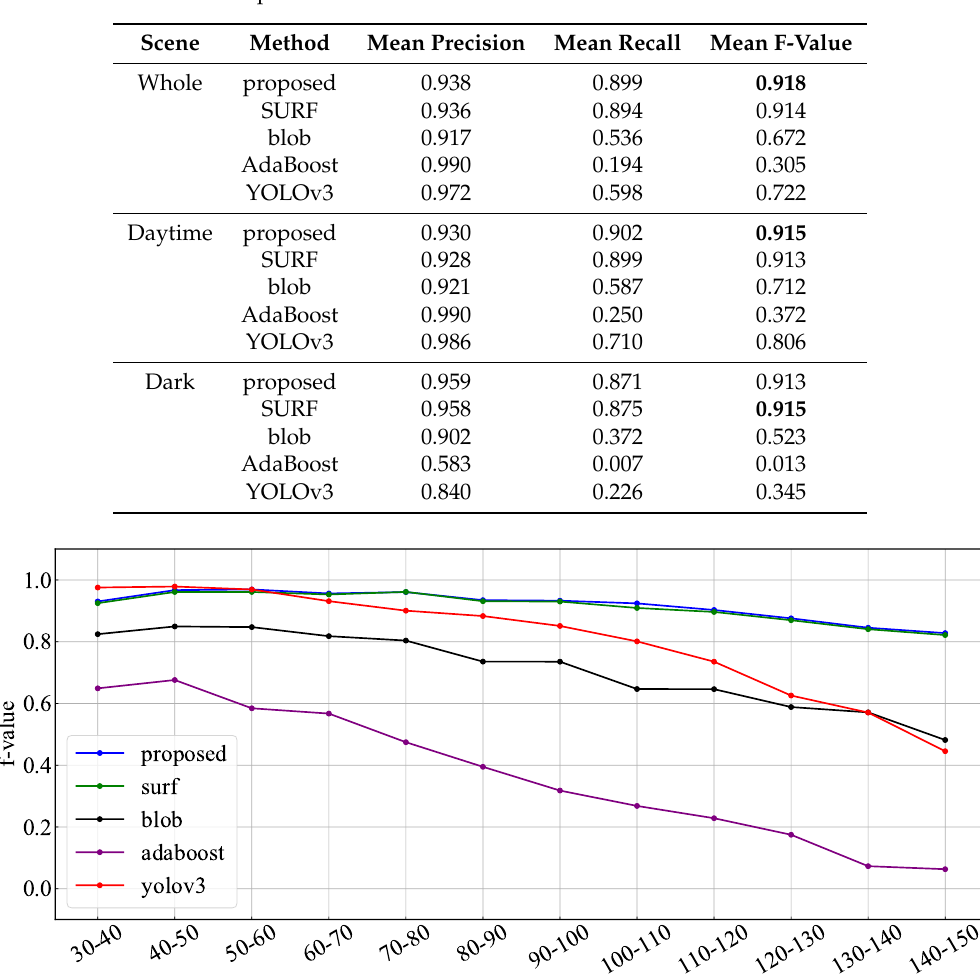
Figure 15. F values for whole data: different candidate extraction methods. Table 6. Experimental results: different candidate extraction methods.